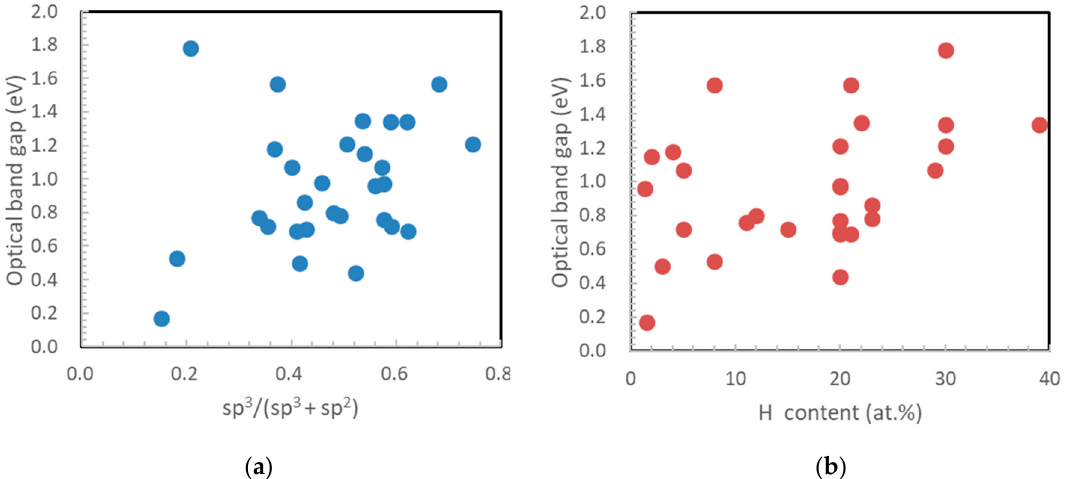
Figure 7. Influence of ( a ) sp 3 ratio and ( b ) hydrogen content on the optical band gap of amorphous carbon films. The correlation coefficients for ( a ) and ( b ) are 0.258 and 0.402, respectively.